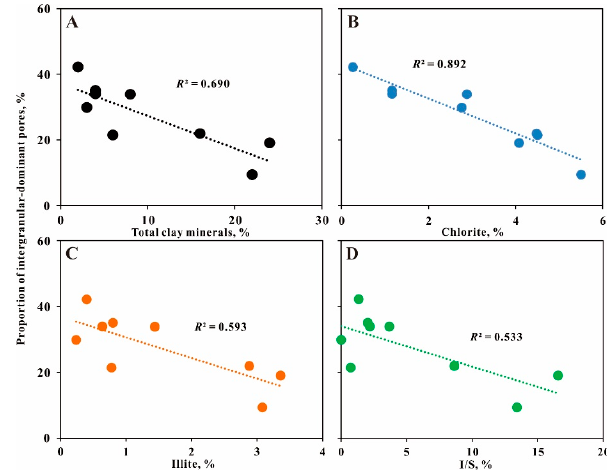
Figure 12. Relationships between contents of total clay mineral ( A ), chlorite ( B ), illite ( C ), I/S ( D ), and proportions of intergranular-dominant pores. The throat radius at inflection point ( r ip ), boundary of intergranular-dominant pores and intragranular-dominant pores, ranges from 0.305 to 0.768 μ m (Table 3), indicating that intragranular- dominant pore networks of different samples correspond to inconsistent throat size distributions due to multiple degrees of diagenesis and different rock compositions [17,58,59]. The values of r ip are negatively correlated with contents of total clay minerals, chlorite, illite, and I/S (Figure 13), and furthermore, chlorite has the relatively stronger control on r ip (Figure 13B), while the correlations between r ip and illite, I/S are fairly poor (Figure 13C,D).This implies that chlorite is more efficient in lowering values of r ip in relative to illite and I/S, due to the fact that chlorite contributes more to intragranular-dominant pore networks, as evidenced by Figure 12.